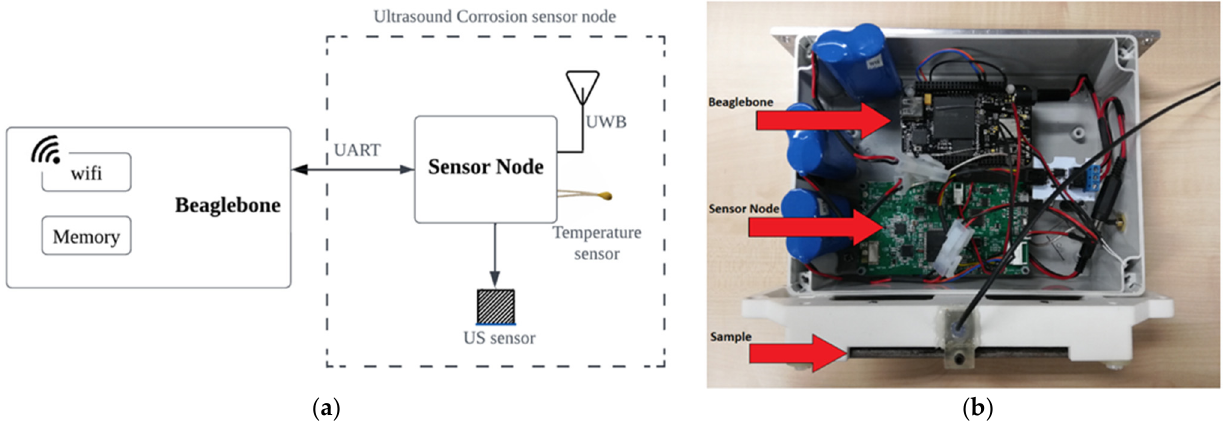
Figure 5. Final electronics setup used in the experiment. ( a ) Block diagram of the setup; ( b ) photo- graph of the actual setup.[12]. graph of the actual setup